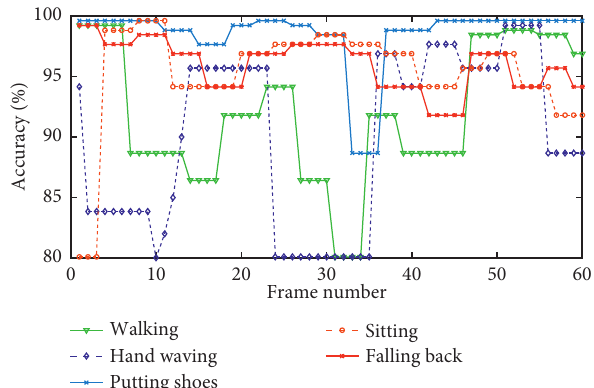
Figure 22: Result of proposal algorithm with real video.